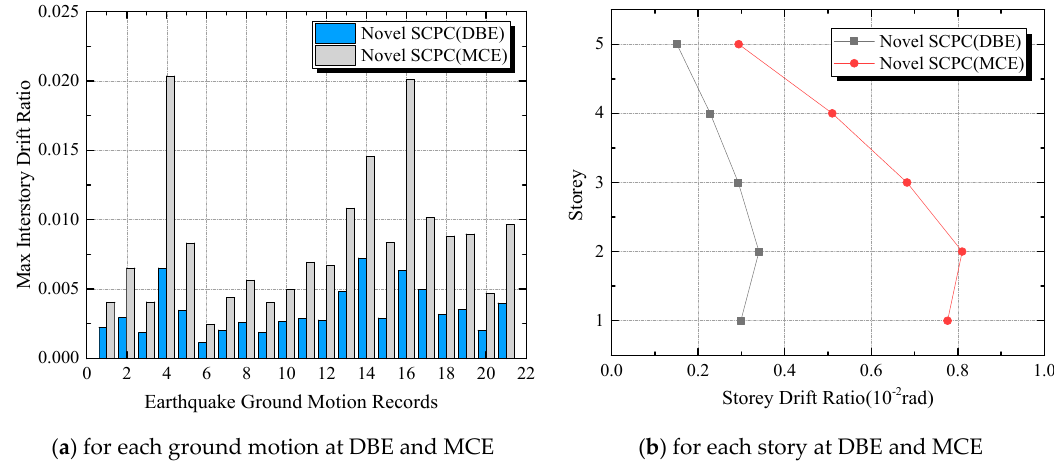
Figure 14. Maximum inter-story drift ratio for each near-fault ground motion and for each story.